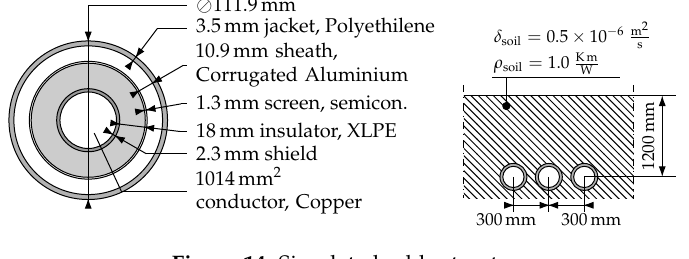
Figure 14. Simulated cable